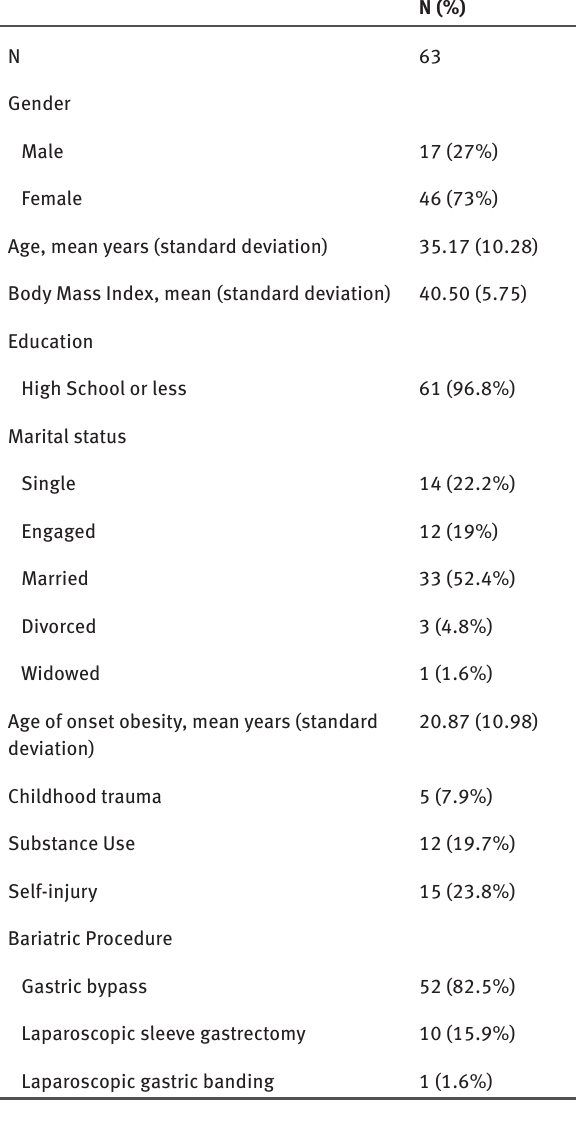
Table 1: Sociodemographic characteristics in obese adult seeking bariatric surgery